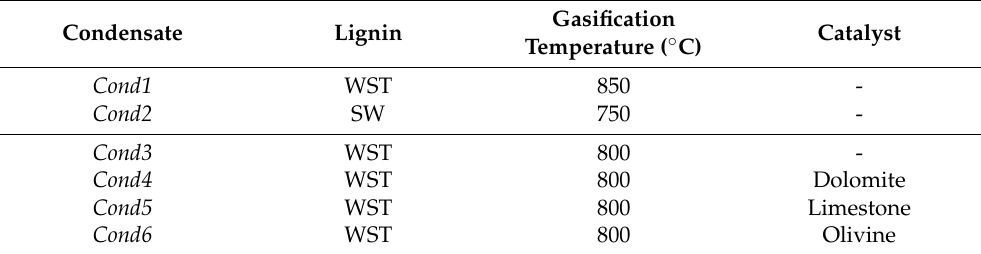
Table 2. Gasification condensates collected and the respective technical lignin type, gasification temperature, and